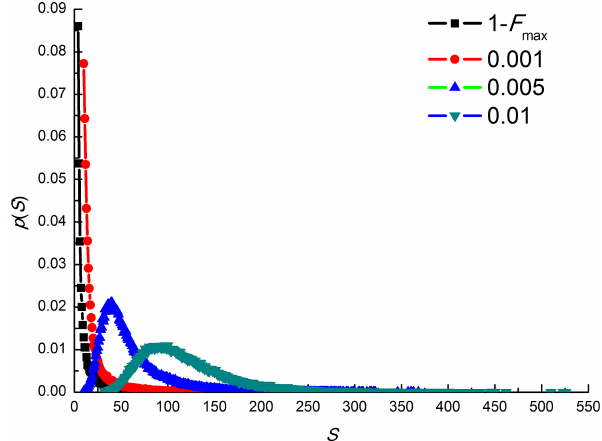
Figure 5. The relation between P(S) and S . The different curves refer to different disturbance